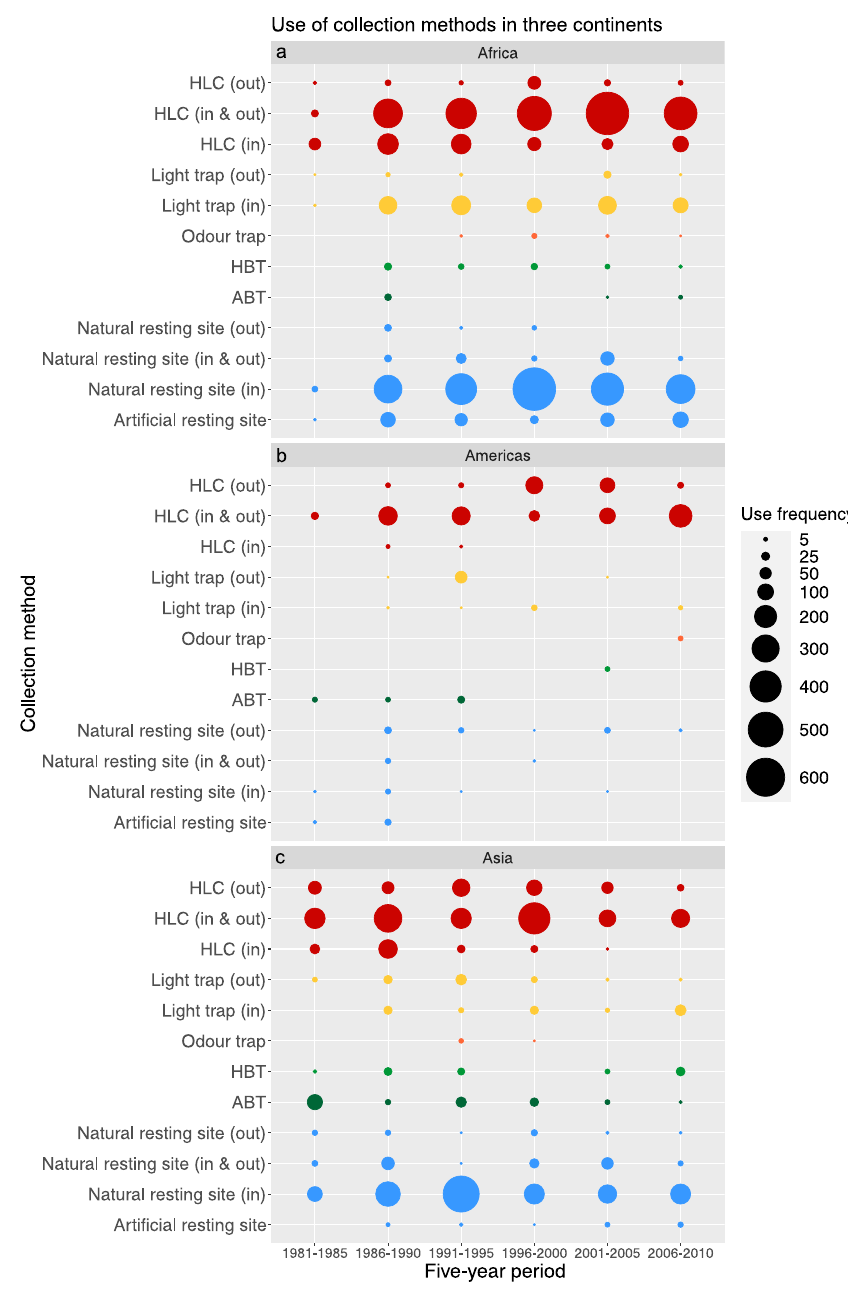
Figure 4. Number of data records per collection method. The number of data records for each collection method used in ( a ) Africa, ( b ) the Americas, ( c ) the Asia-Pacific region, presented per 5-year time period. ABT = animal-baited trap, HLC = human landing catch, HBT = human-baited double net